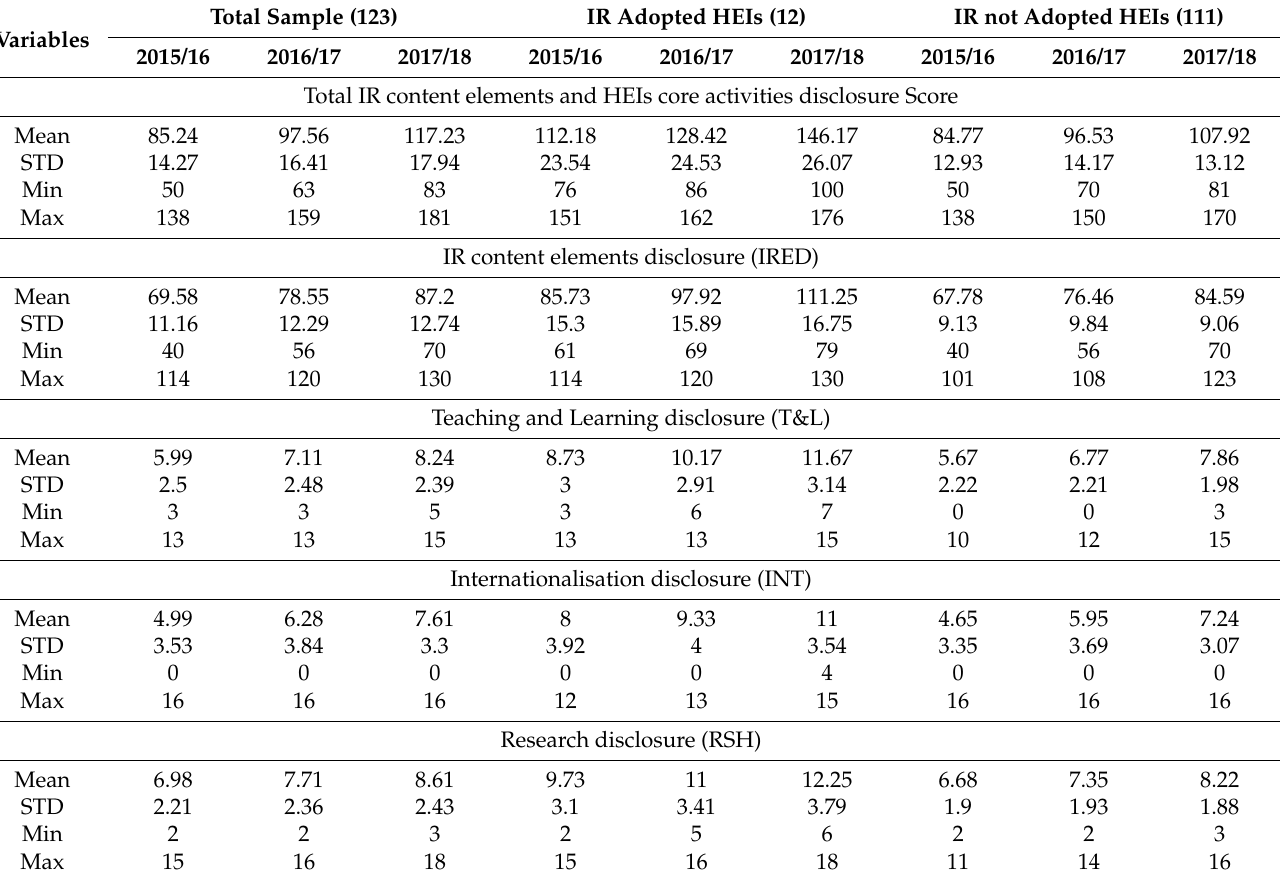
Table 3. Relationship between integrated reporting content elements and HEIs core activities and IR adoption for the study